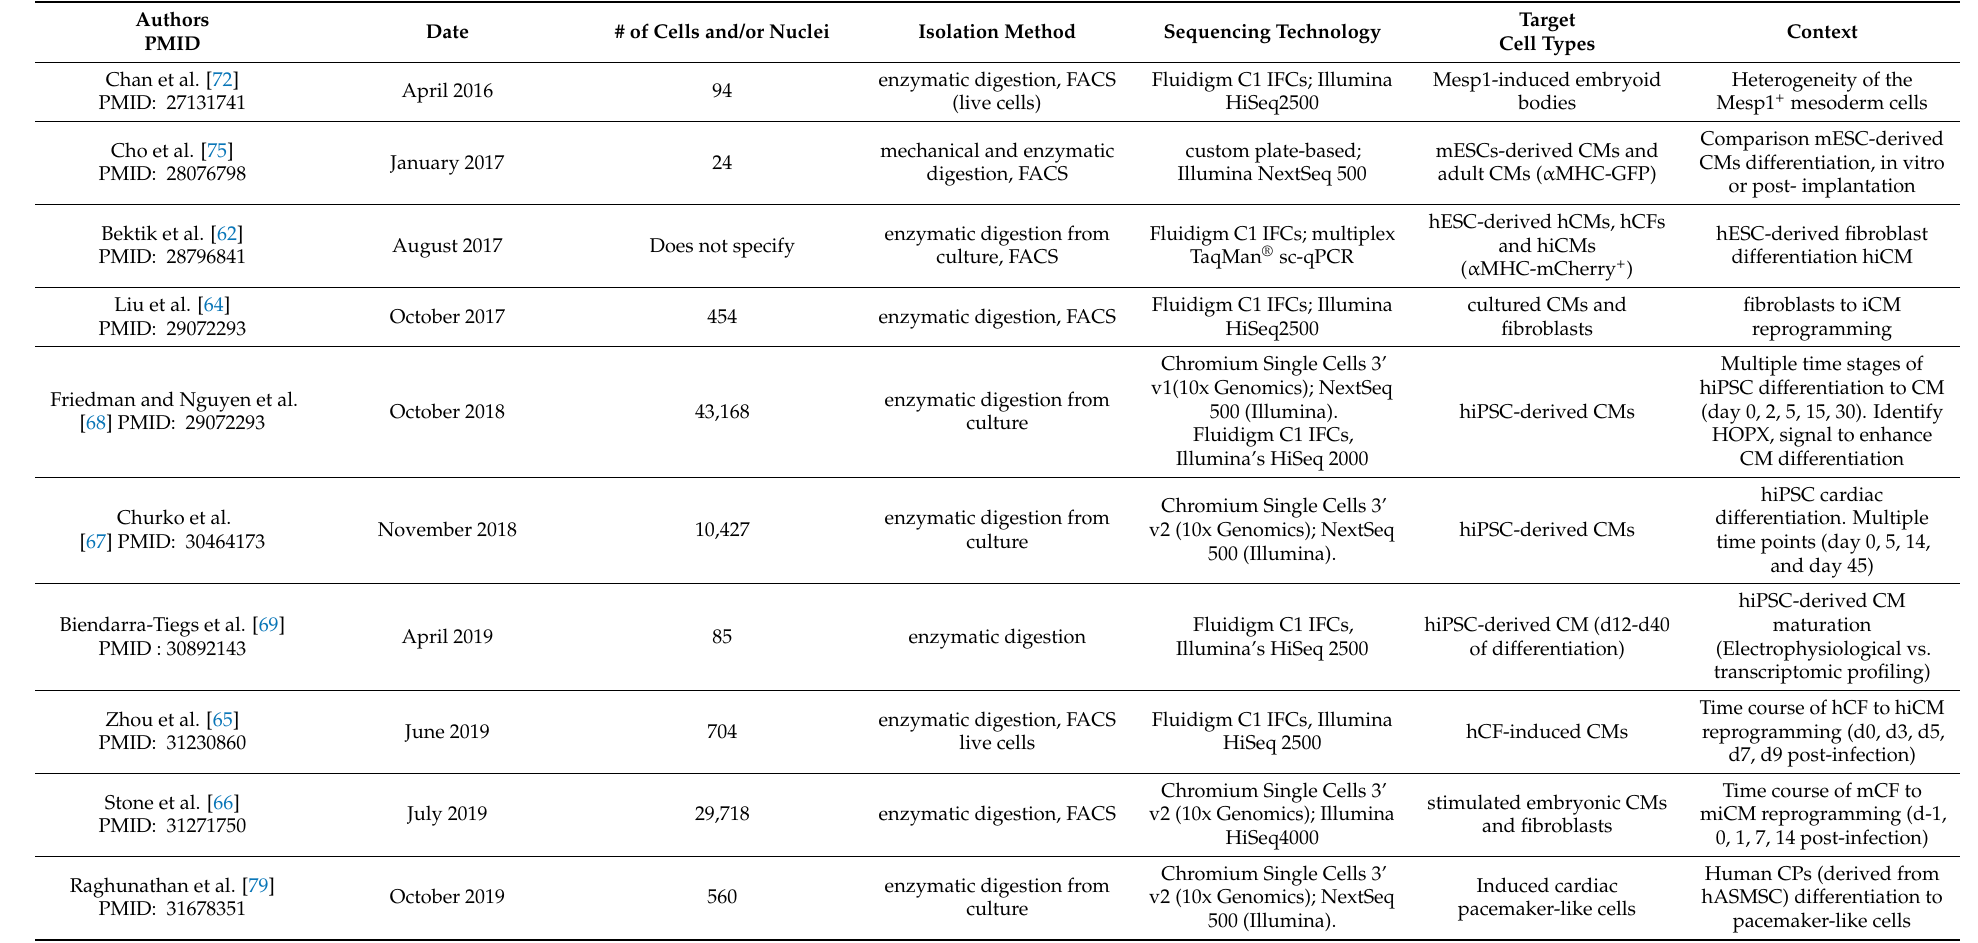
Table 2. In Vitro Cardiac Cell Differentiation- Embryonic and Pluripotent Stem